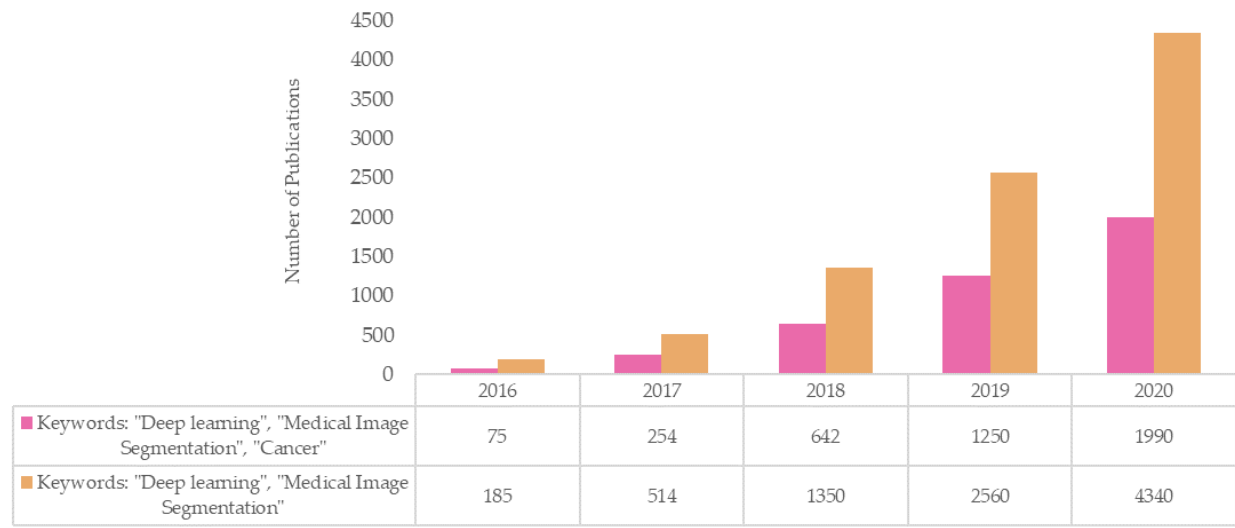
Figure 1. Rapid rise in the number of publications for DL-based segmentation research in medical imaging where almost half of studies were cancer-related between 2016 and 2020.